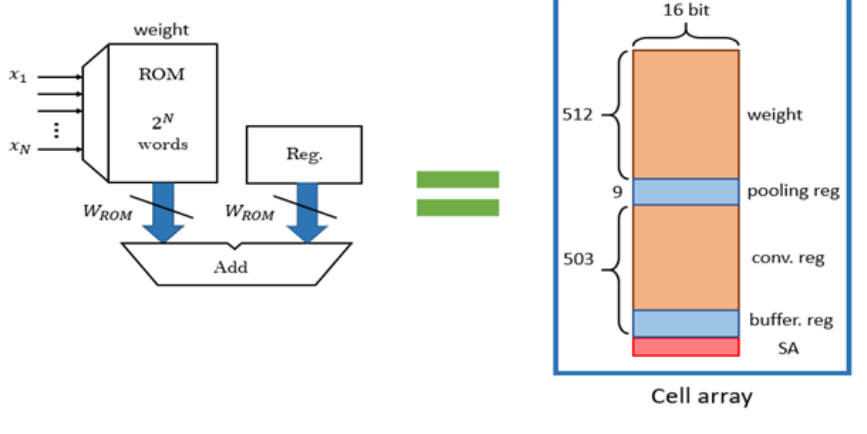
Figure 6. Our CIM circuit